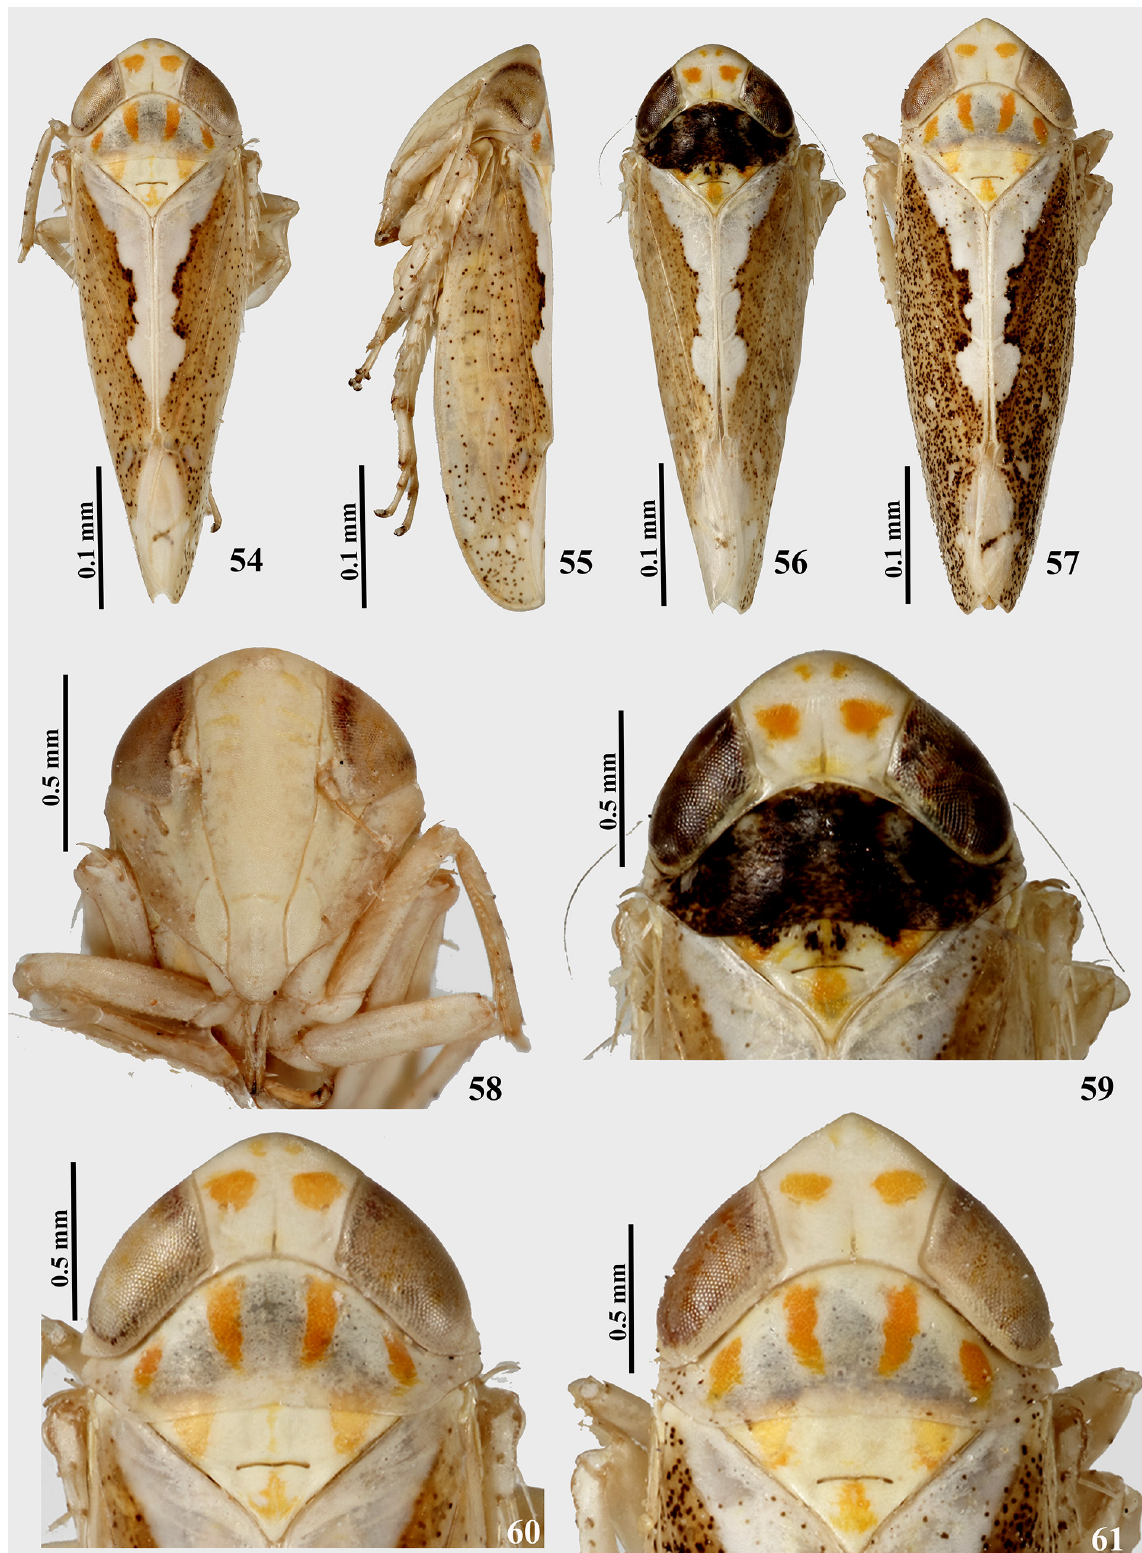
Figs 54−61. Oshaibahus zizyphi (Bergevin, 1922) gen. et comb. nov. 54 , 56 – 57 . Dorsal view. 55 . Lateral view. 58 . Face. 59 – 61 . Dorsal view of head and